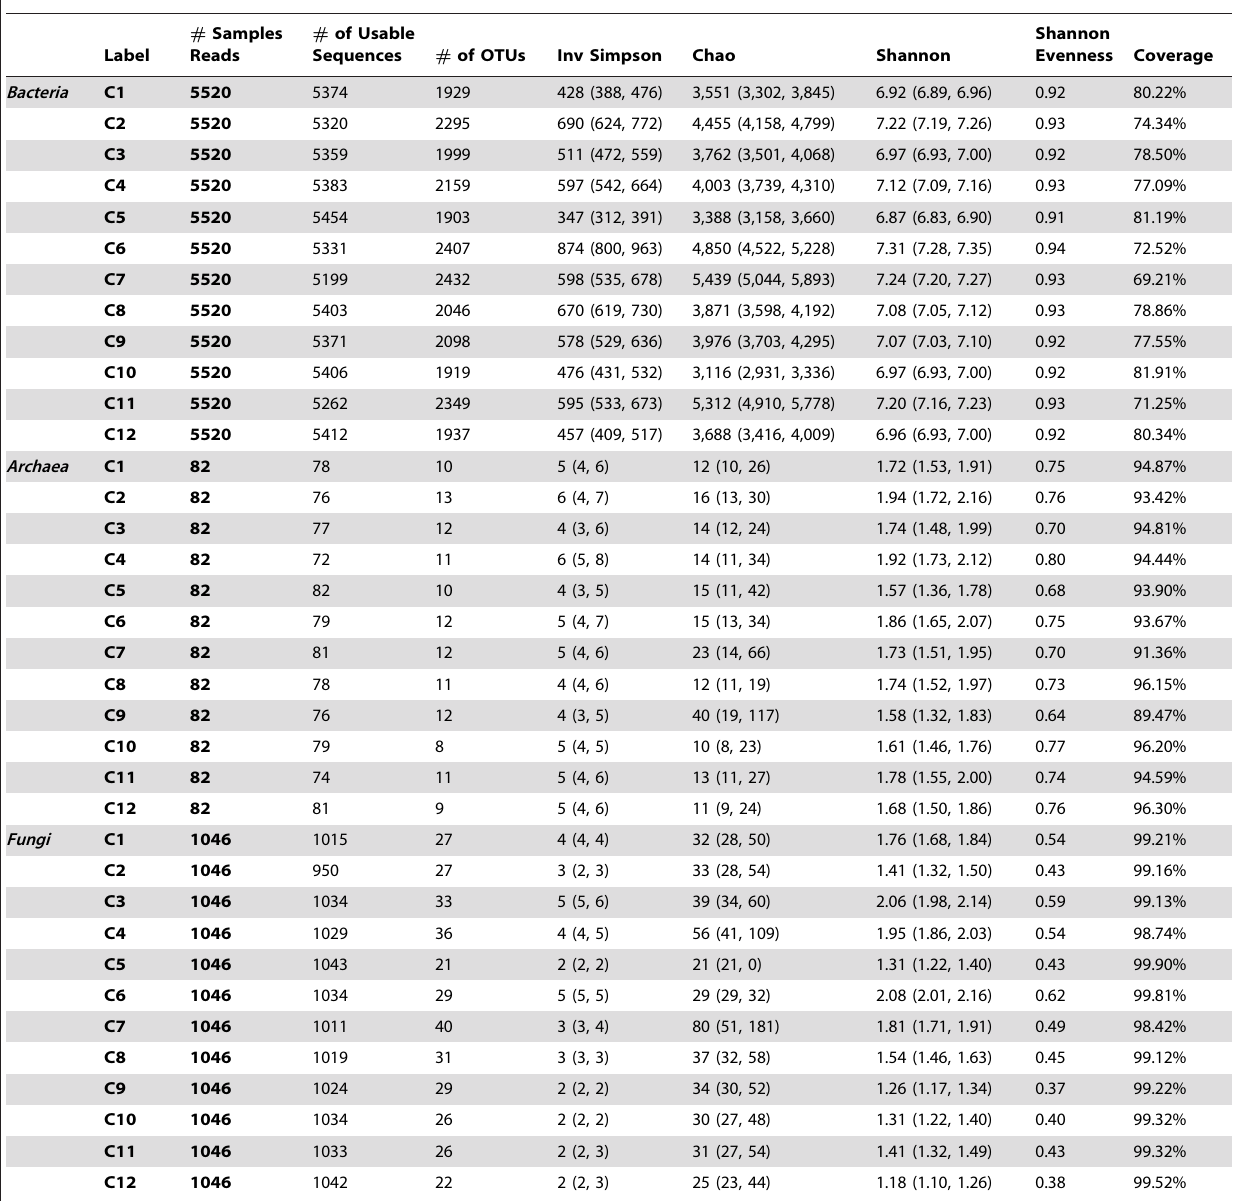
Table 2. Sampling microbial diversity across 12 cows.